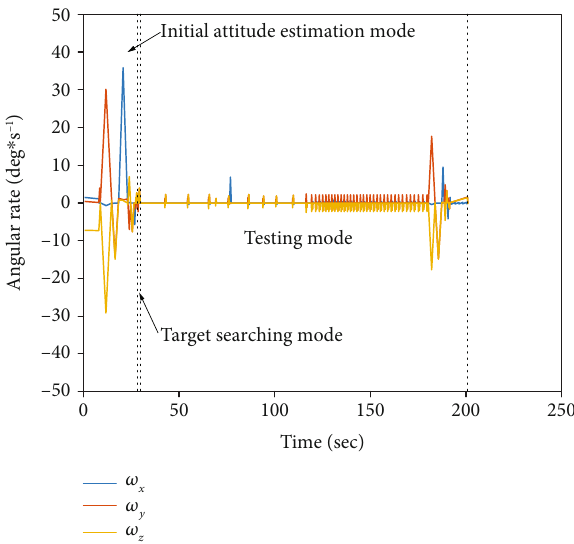
Figure 5: Time history of angular rate during all modes.